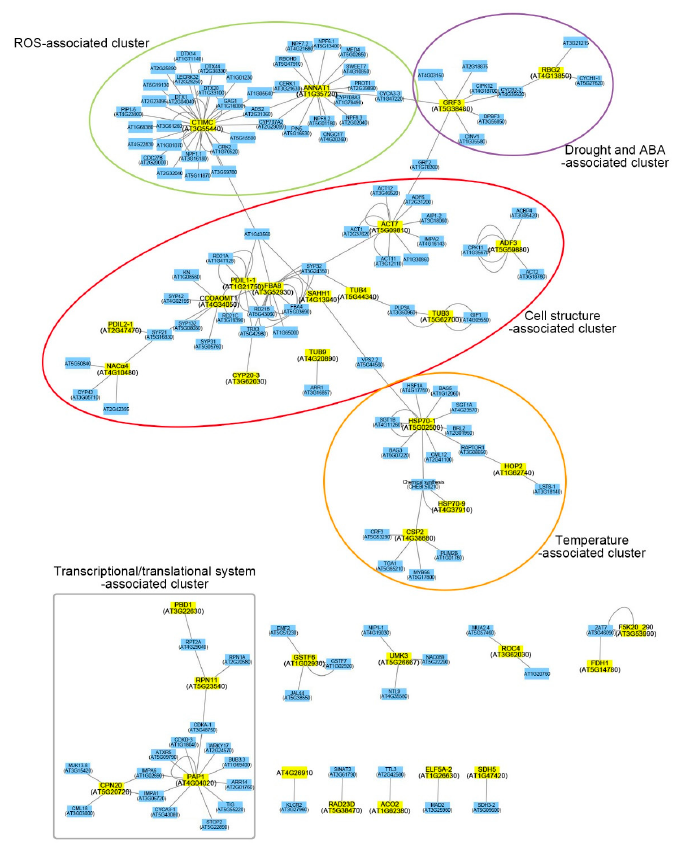
Figure 4. Interaction network analysis with DEPs by the Cytoscape software platform using IntAct molecular interaction database. Yellow squares indicate proteins of the input lists, whereas blue squares indicate proteins of physical interaction.